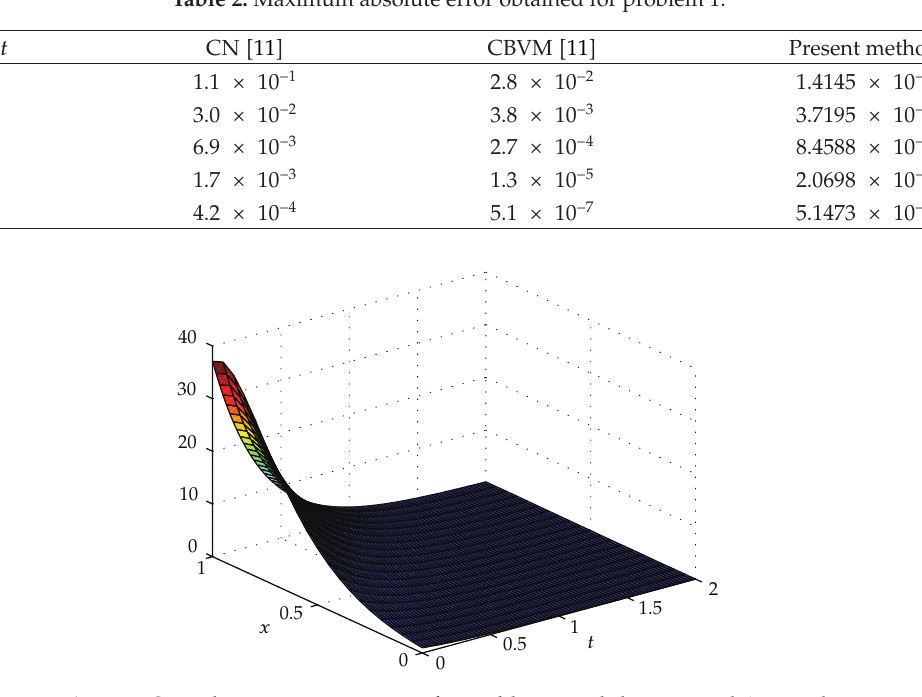
Figure 1: Spatial-time approximations for problem 2 with h (cid:7) 0 . 05 and Δ t (cid:7) 0 . 5 h